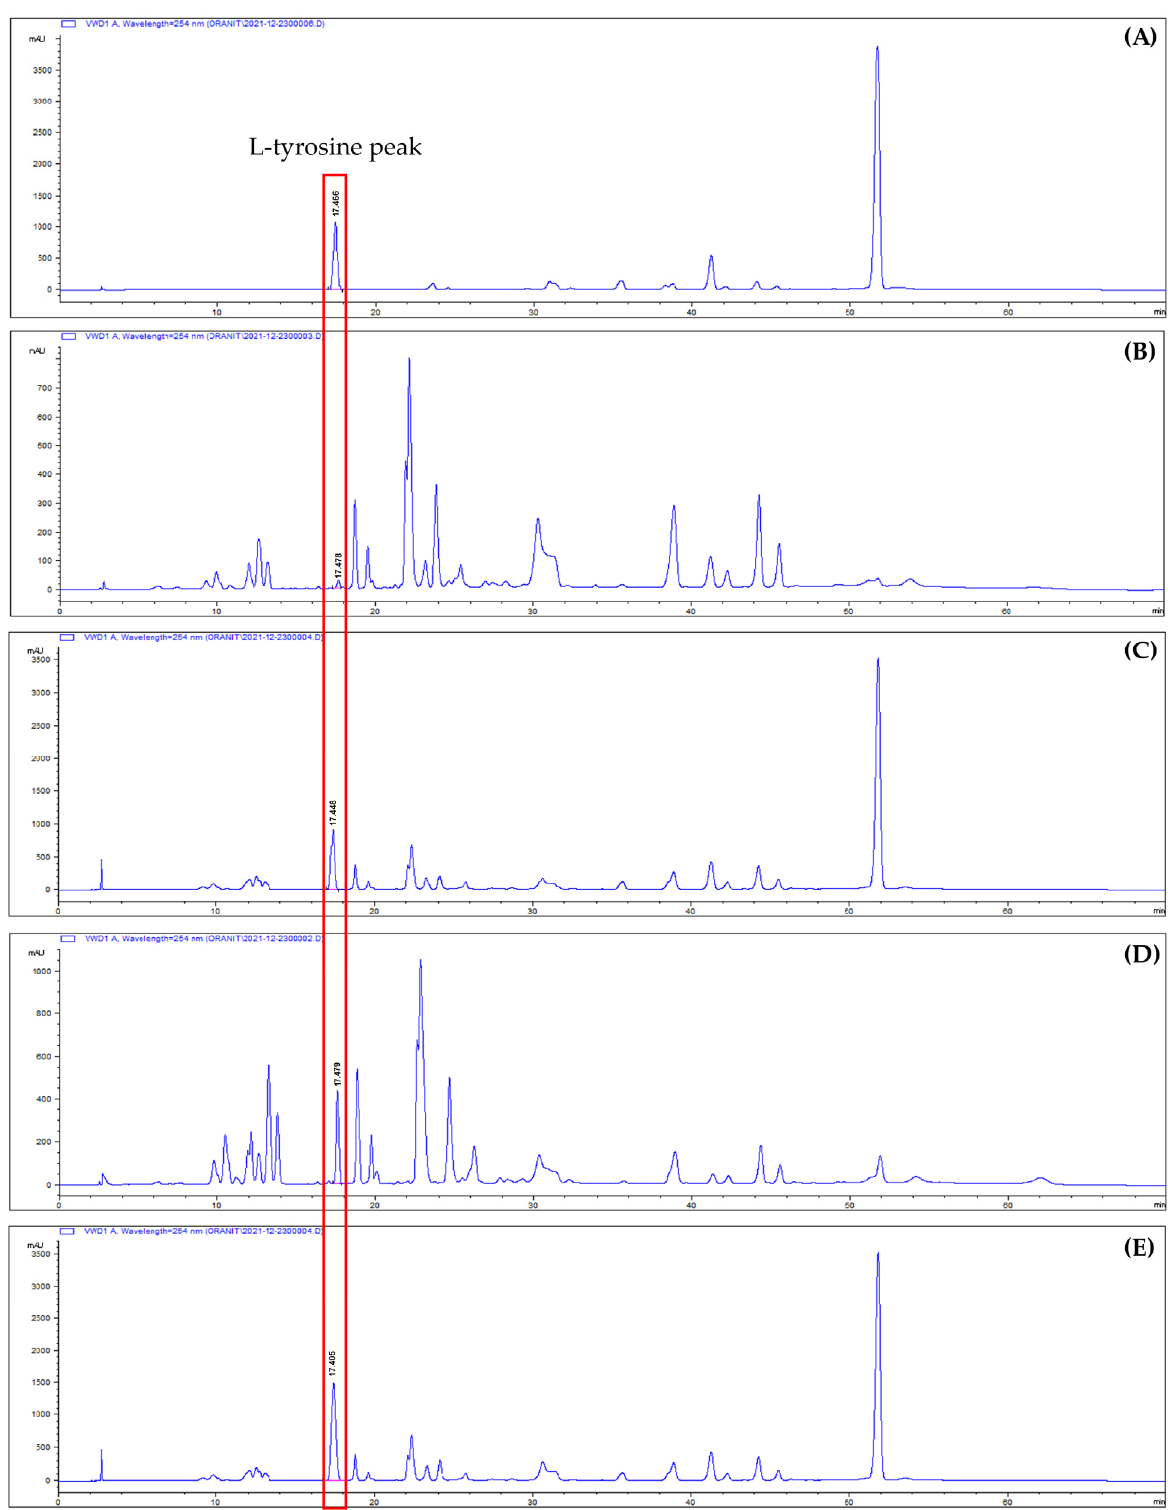
Figure 2. The HPLC chromatogram displays the peak area (mAU) of L-tyrosine in various samples at a retention time of approximately 17.455 ± 0.027 min: ( A ) The standard L − tyrosine (15,635.10 mAU); ( B ) F − DBRH (388.5 mAU); ( C ) F-DBRH mixed with L − tyrosine (16,023.6); ( D ) HAO-DBRH (5091.3 mAU); and ( E ) HAO-DBRH mixed with L − tyrosine (20,726.4